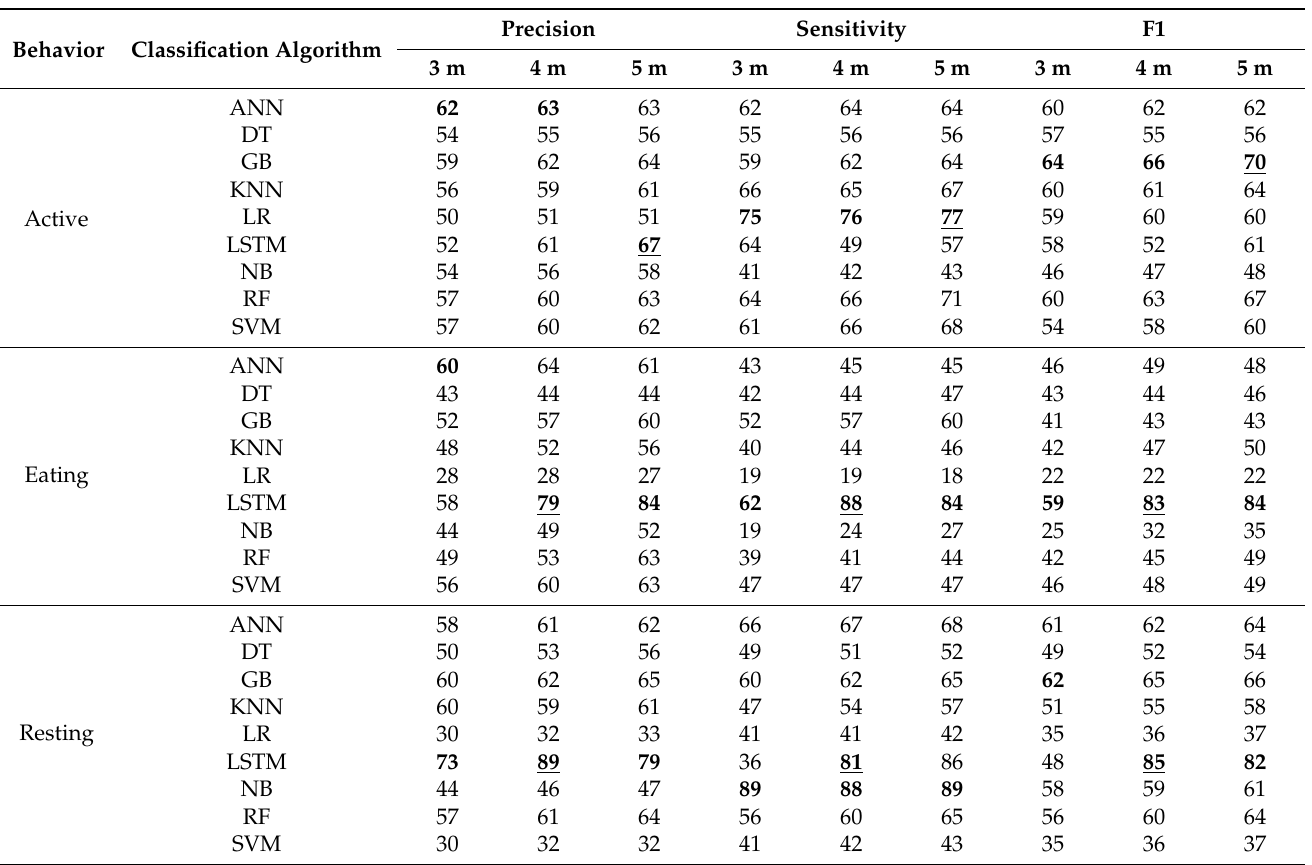
Table 3. Classification performance of the collar-fitted accelerometer sensor based on nine algorithms framed at different minute window sizes for specific the active, eating, and resting behaviors of the